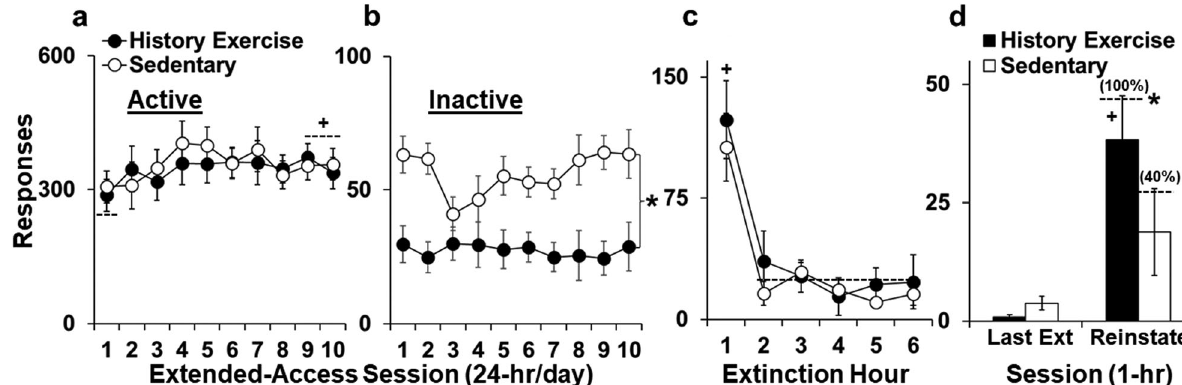
Fig. 4 Effects of discontinued high-access exercise on extended-access fentanyl self-administration and subsequent relapse vulnerability. Number of active ( a ) and inactive ( b ) responses (± SEM) for each of the ten extended-access sessions for the history of exercise and sedentary groups. Number of responses (± SEM) for the fi rst six extinction sessions run ( c ) and the last extinction session versus the reinstatement session ( d ) for the history of exercise and sedentary groups. The numbers in parenthesis are the percentage of rats within each group that showed reinstatement of responding (higher responses during reinstatement compared to the last extinction session). + Signi fi cant difference between sessions 1 and 9 – 10 ( P < 0.05; a ), sessions 1 and 2 – 6 ( P < 0.001; c ), and the last extinction session versus reinstatement ( P < 0.05, d -history of exercise). *Signi fi cant difference in percent group reinstatement ( P < 0.05; d